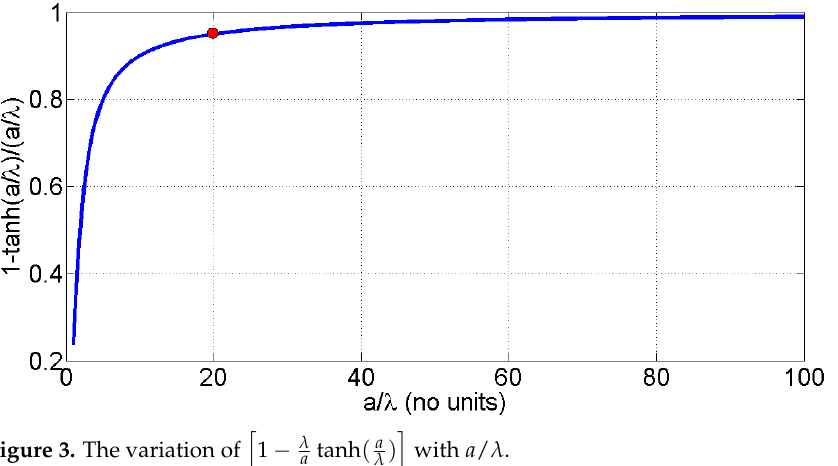
Figure 3. The variation of Comparing Equations (3) and (37), the characteristic length scale Λ (m) is obtained for fractured media